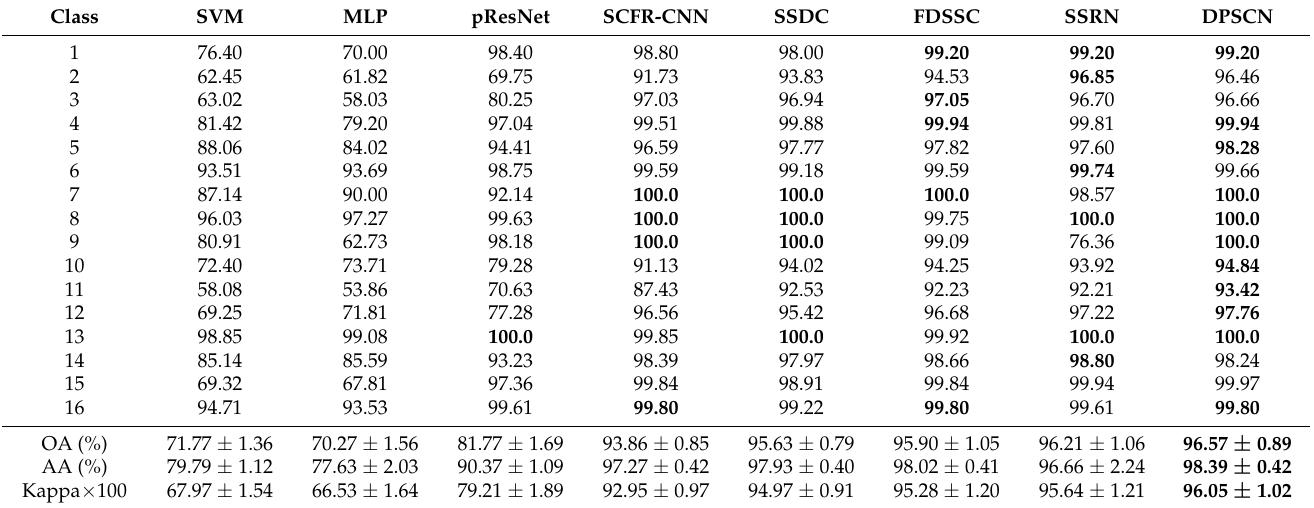
Table 6. Classification results of the different models for the IP data set.